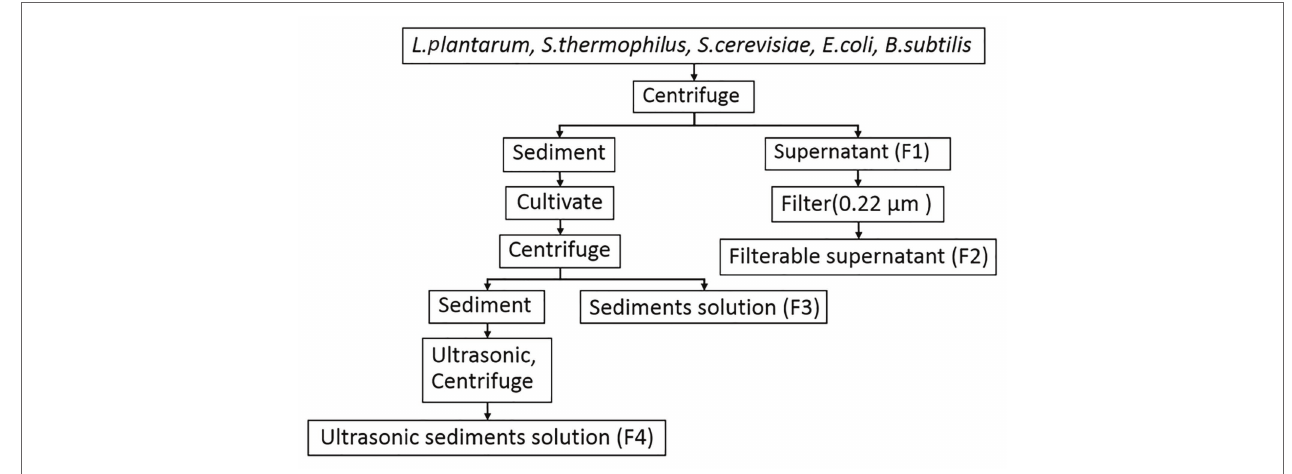
FIGURE 1 | The flow diagram for the treatment of the supernatant and sediment from microorganisms used in this